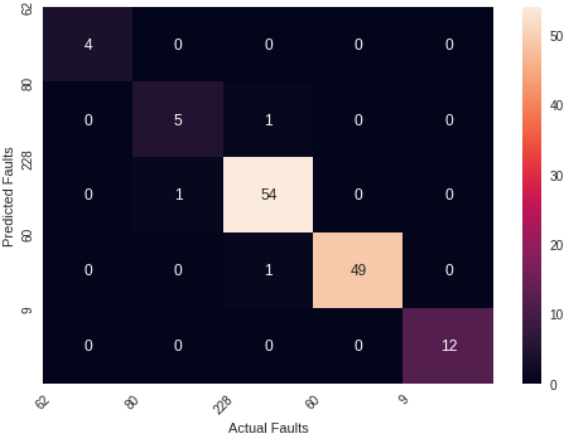
Figure 11. Confusion matrix of faults.